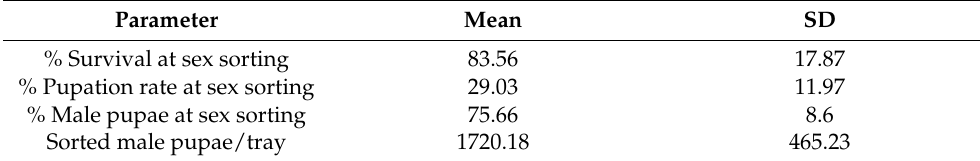
Table 6. Parameters of pupation at sex